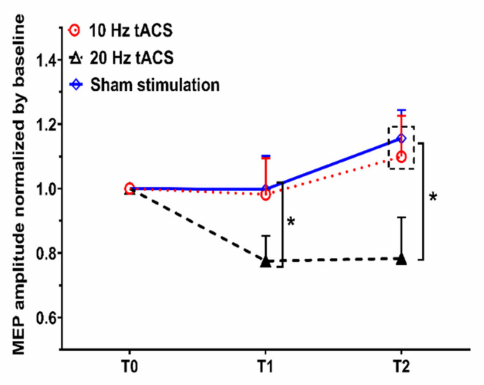
Figure 2. Impact of tACS on motor cortex excitability. Either tACS at 10 Hz and 20 Hz or a sham stimulation was applied over the left M1 during the action observation, followed by the action execution. Motor-evoked potentials (MEPs) were recorded before the action observation (T0), immediately after the action observation (T1), and after the action execution (T2). Each intervention condition included 16 participants. Error bars represent the standard error of means. MEP amplitudes significantly decreased following 20 Hz tACS at time T1 and T2, in contrast with the sham stimulation. MEPs were significantly reduced in the 20 Hz tACS condition at time T2 in comparison with the 10 Hz tACS condition but did not significantly change at time point T1 between the 20 Hz and 10 Hz tACS conditions. There were no significant differences at time point T1 and T2 between the 10 Hz tACS condition and the sham stimulation. * denotes significant differences between groups (* p < 0.05).